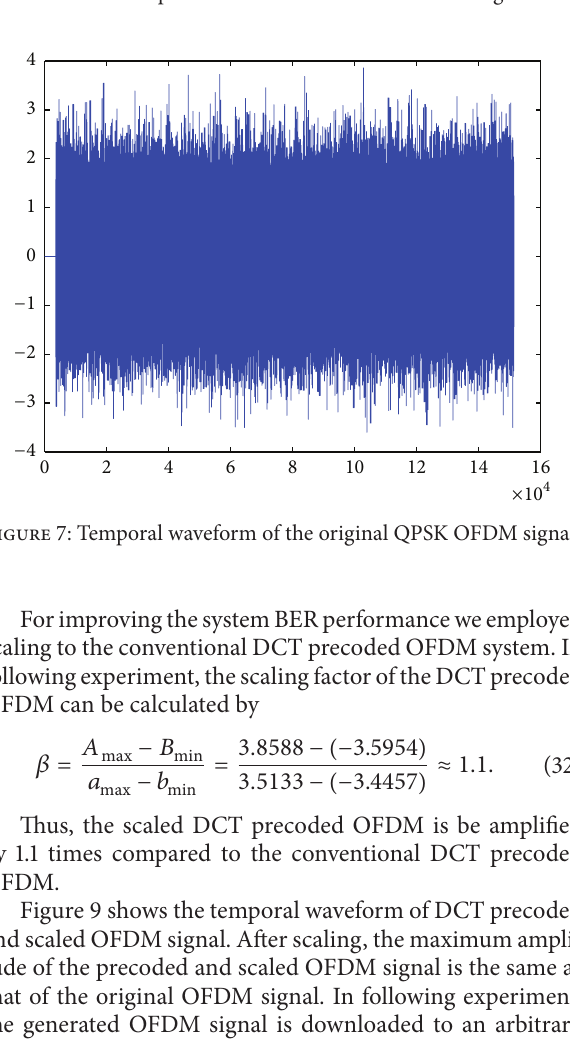
Figure 6: Comparison of the PAPRs of the OFDM signals.